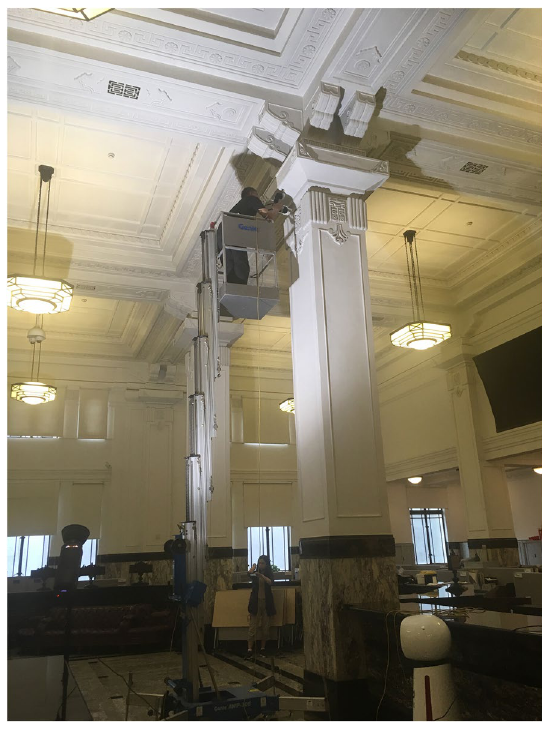
Fig. 5 On-site investigation of finishes and sampling conducted using a lift crane. (Source: the